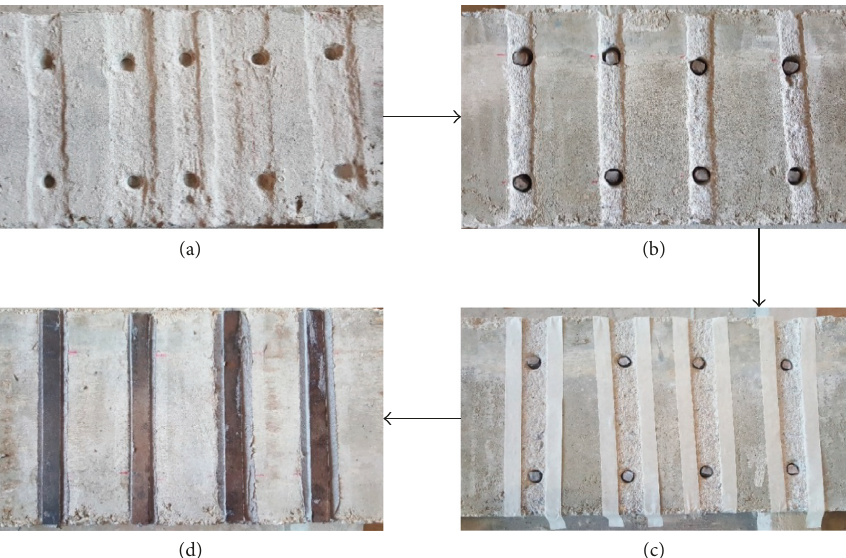
Figure 2: Shear strengthening of RC beam using steel plate and embedded connector: (a) surface preparation with hole of connector; (b) embedded connector; (c) prepared surface and connector for strengthening; (d) shear-strengthened